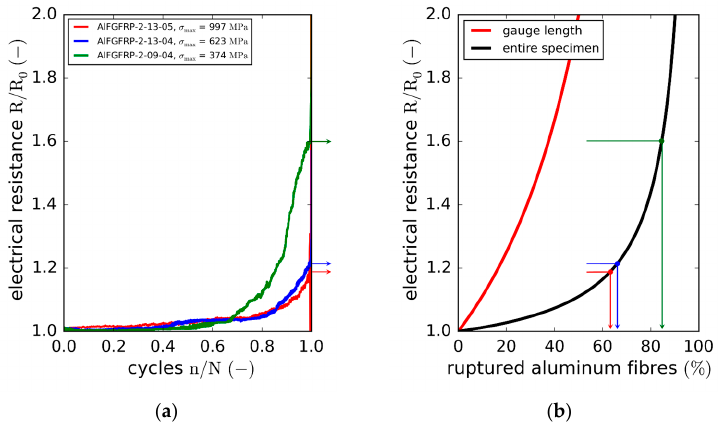
Figure 22. ( a ) Development of the electrical resistance of contacted AlFGFRP-2 specimens under fatigue loads; ( b ) analytically calculated resistance increases due to the gradual one-by-one ruptures of the parallel non-touching aluminum fibers, according to Equation